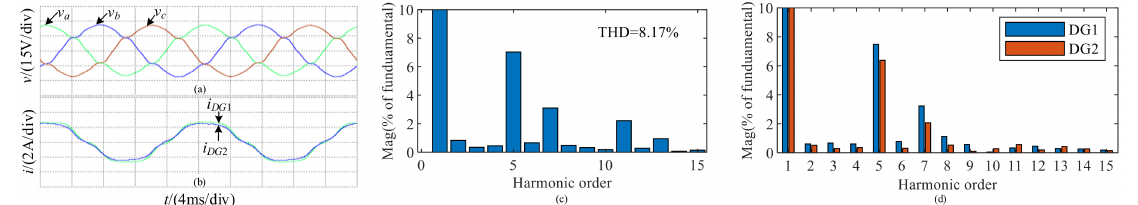
Figure 13. The experimental results of the traditional control method under the non-linear load connected to the PCC: ( a ) PCC voltage; ( b ) Phase A output current of DGs; ( c ) FFT analysis of phase A voltage of PCC; ( d ) FFT analysis of phase A output current of DGs.